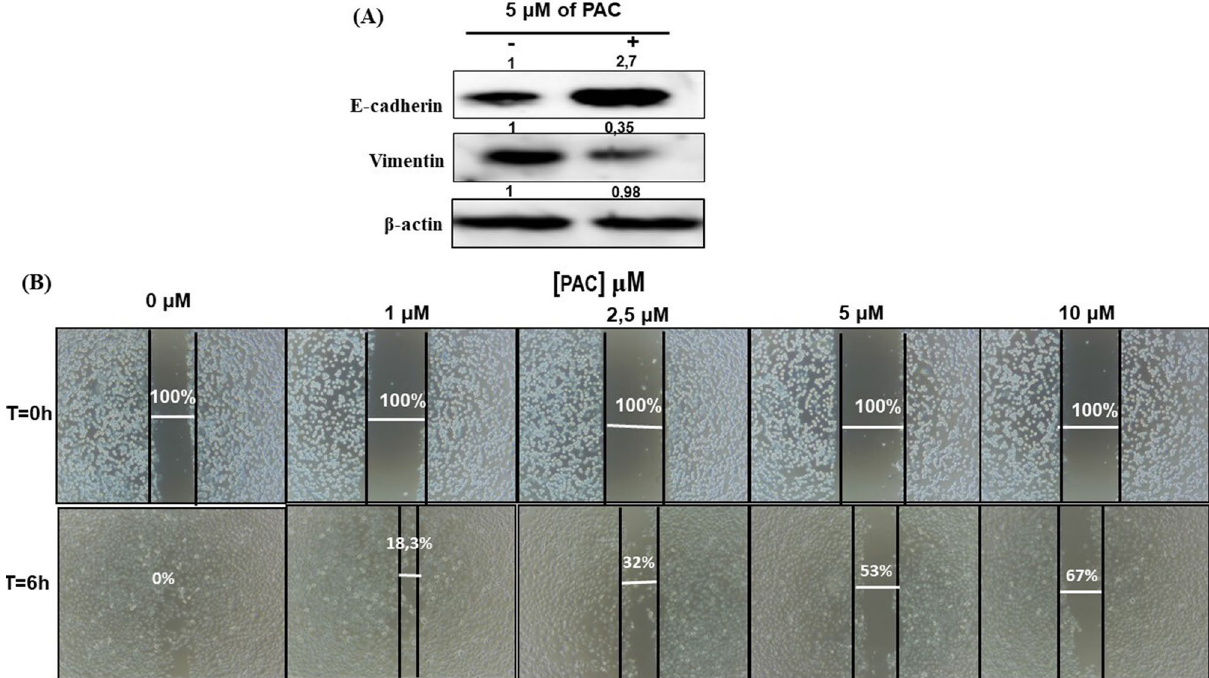
Figure 6. PAC suppresses the process of epithelial-to-mesenchymal transition and inhibits cell migration in oral cancer cells. ( A ) PAC at 5 µM inhibits the EMT in oral cancer cells by increasing E-cadherin expression, while vimentin expression was decreasing (n = 3). ( B ) Wound Healing (Scratch) Assay: after 6 h of treatment, PAC dose-dependent inhibits ca9-22 cell migration (n = 3). All Blots derive from the same experiment and were exposed at same time of phosphor imager